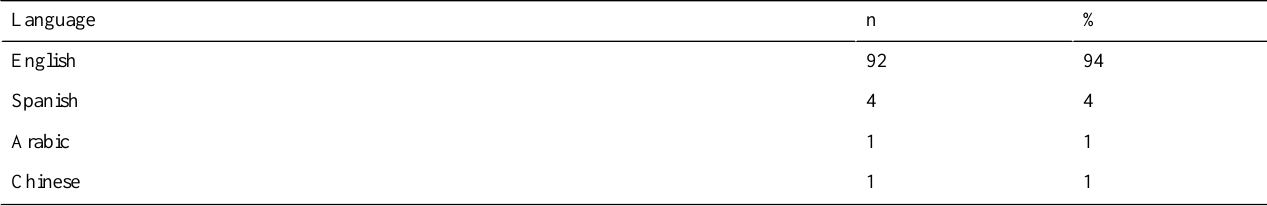
Table 3. MOOCs by language (n=98).